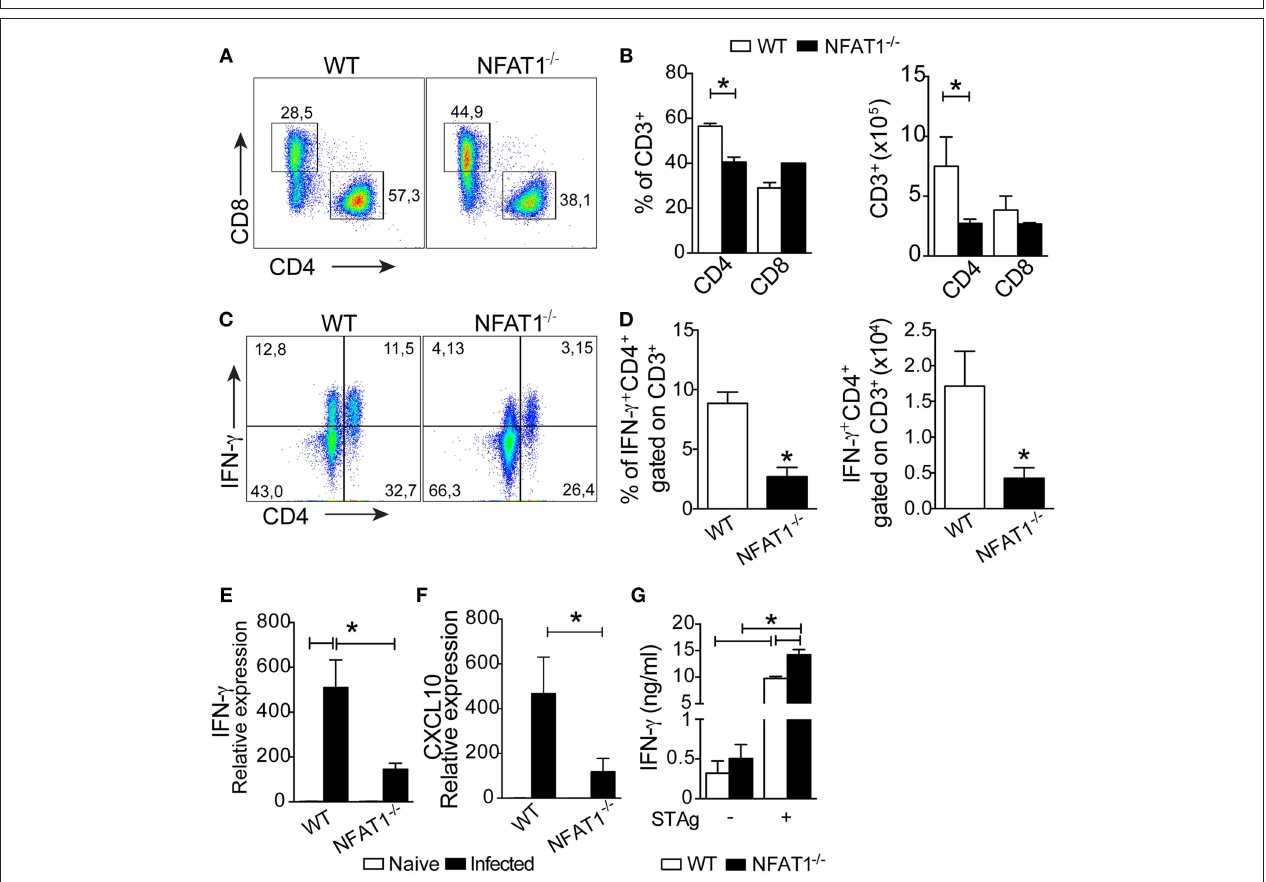
FIGURE 4 | NFAT1 controls the recruitment of CD4 + T cells to the CNS. Mononuclear cells from the CNS of WT and NFAT1 − / − mice at 25 dpi with T. gondii were stained for CD4 and CD8. Dot plots (A) and graph bars (B) show the frequency and absolute number of CD4 + and CD8 + cells gated on CD3 + cells obtained by flow cytometry. The percentages and absolute numbers of IFN- γ -expressing CD4 + cells gated on CD3 were determined by flow cytometry in mononuclear cells isolated from the CNS that were stimulated with phorbol 12-myristate 13-acetate plus ionomycin for 4h for intracellular staining (C,D) . The relative expression of IFN- γ (E) and CXCL10 (F) . The levels of IFN- γ were measured in the culture supernatants of splenocytes from WT and NFAT1 − / − mice infected with T. gondii and stimulated with T. gondii tachyzoites soluble antigen (STAg) for 72h (G) . Data are expressed as the mean ± SEM of five mice per experimental group of two independent experiments (* P <